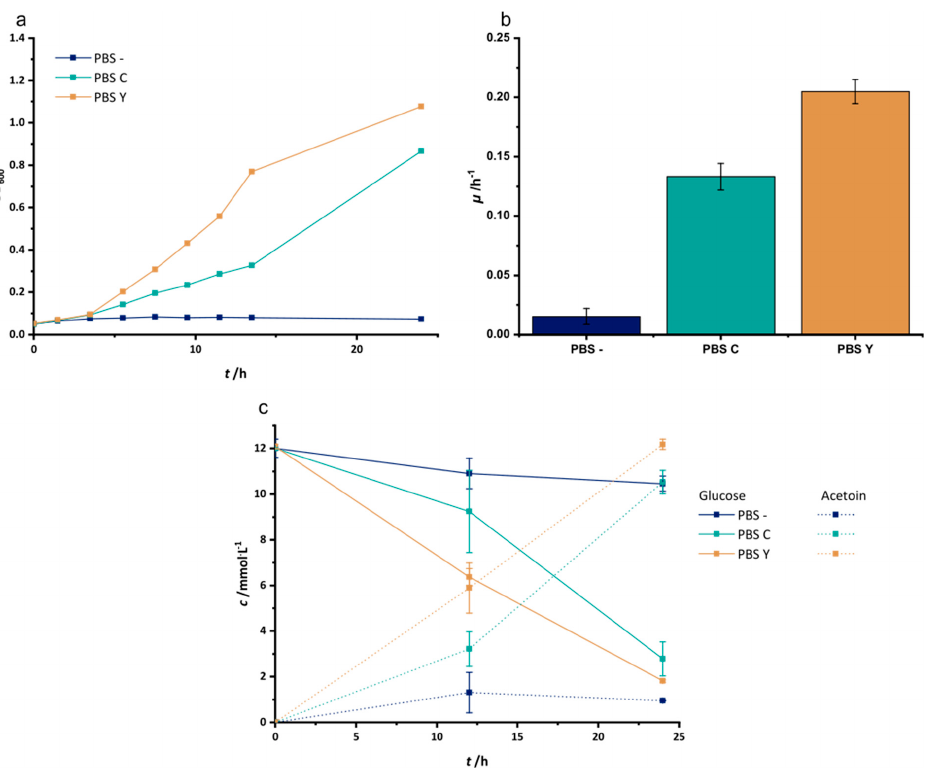
Figure A1. Influence of media supplementation on the metabolic rate of JG991. ( a ) shows the anaerobic growth of JG991 in PBS minimal medium with 40 mmol / L NO 3 − and 12 mmol / L Glucose supplemented with 0.1% casein hydrolysate (PBS C) or 0.1% yeast extract (PBS Y). PBS—is without supplementation. The growth rates are represented in ( b ). The analysis of substrate consumption and product formation is represented in ( c